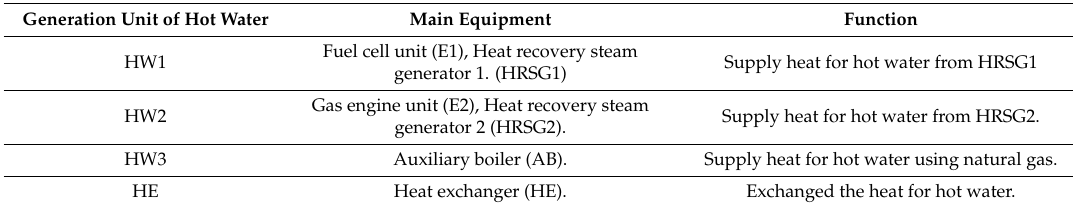
Table 9. The hot water subsystem of the CCHP system.